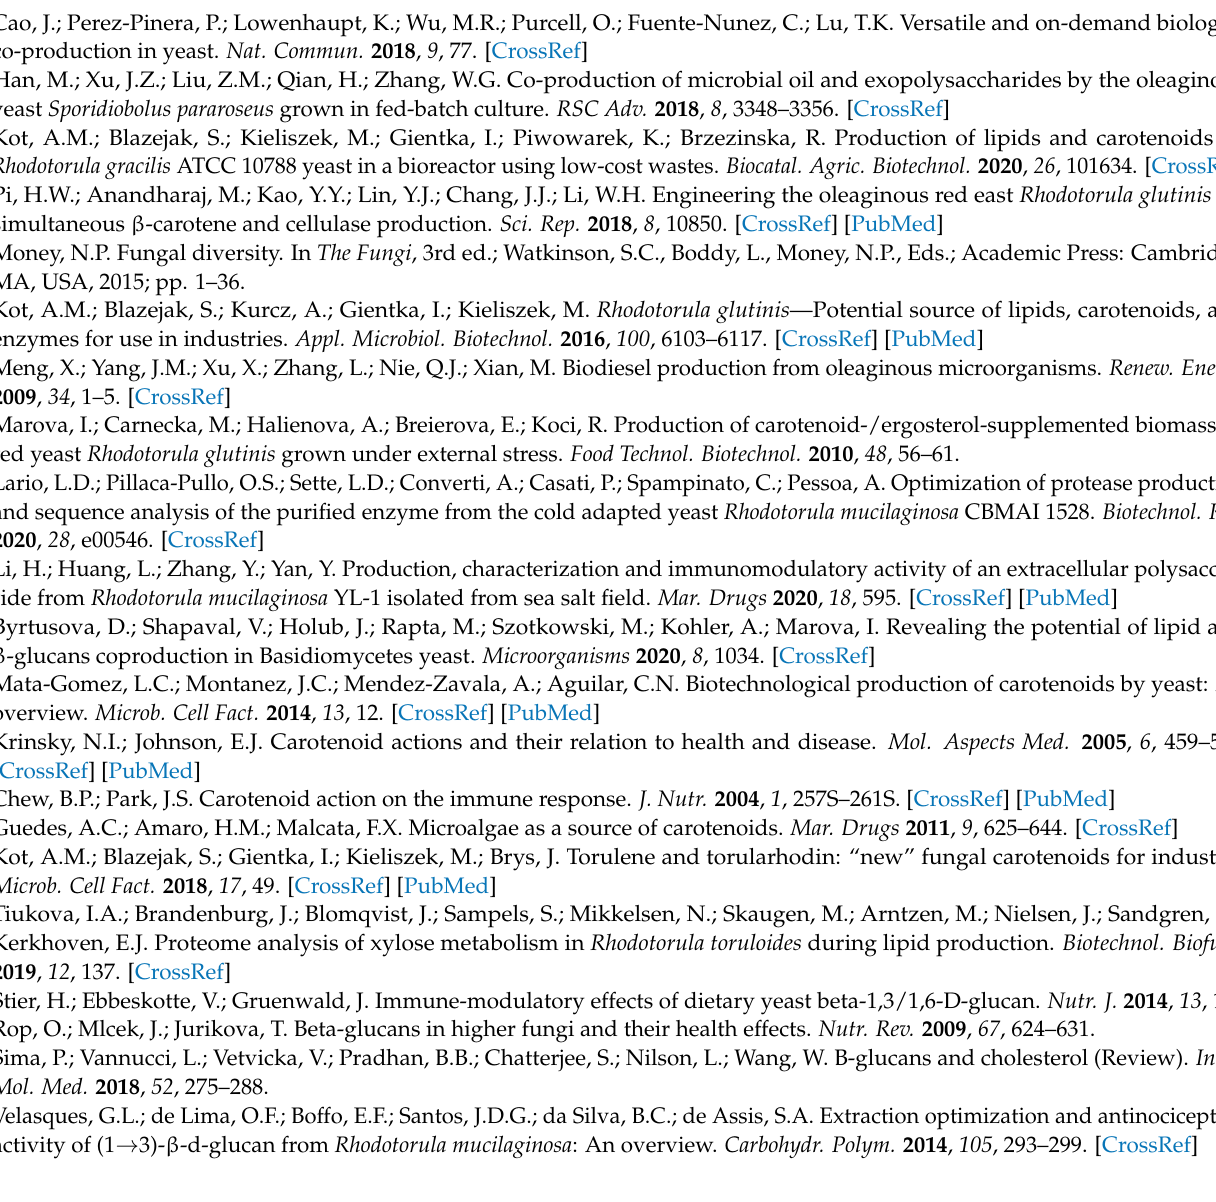
Figure S8: Distribution of carotenoid pigments produced by R. kratochvilovae (mannose medium; different C/N ratio; 96 h